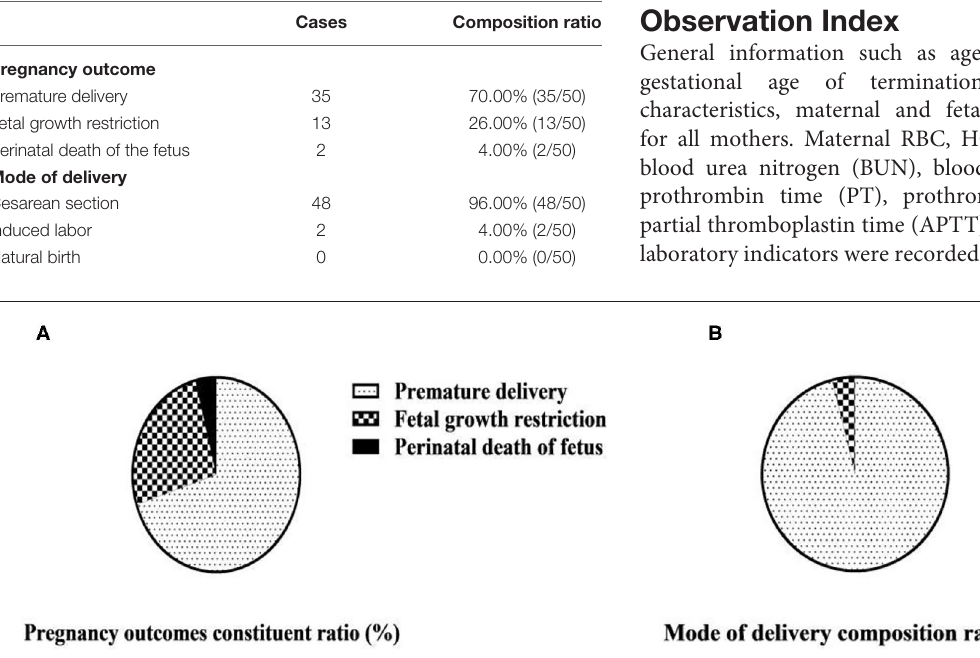
FIGURE 2 | Pregnancy outcomes and mode of delivery composition ratio of 50 maternities in the observation group ( n , %). (A) Pregnancy outcomes of 50 maternities in observation group; (B) Mode of delivery of 50 maternities in observation